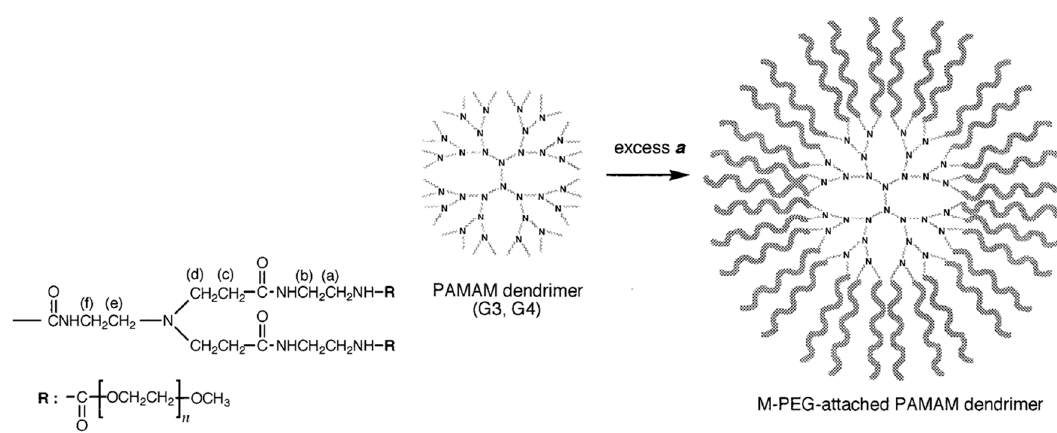
Figure 47. PEGylation of G3, G4; amine-terminated poly(amidoamine) (PAMAM) dendrimers produced dendritic (core)-linear (shell) architectural copolymers with enhanced unimolecular micelle encapsulation properies for guest molecules (i.e., anti-cancer drugs) such as adrimyicin and methotrexate. Reprinted with permission from [114]. Copyright 2000 American Chemical Society.